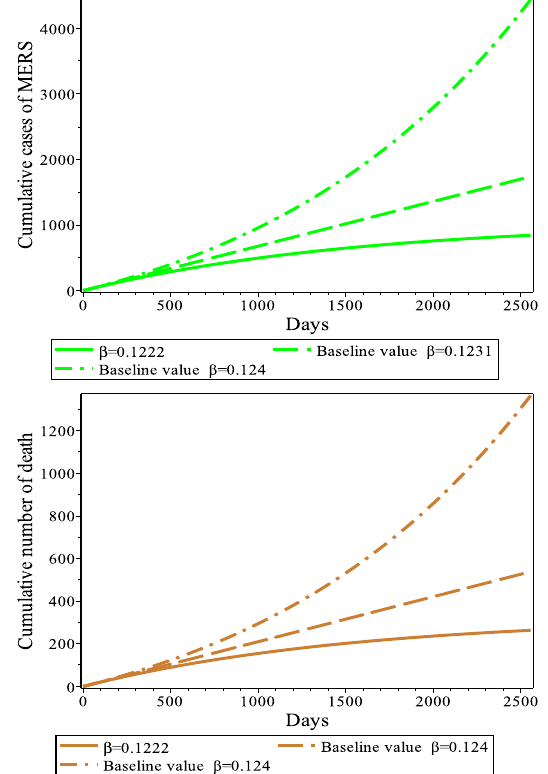
Fig. 8: Riyadh: Simulation results for the cu- mulative reported cases of MERS (left) and the cumulative number of deaths (right). Parameter values used are β = 0 . 1222 – dashed curves, β = 0 . 1231 – solid curves, and β = 0 . 124 – dashed dot curves.